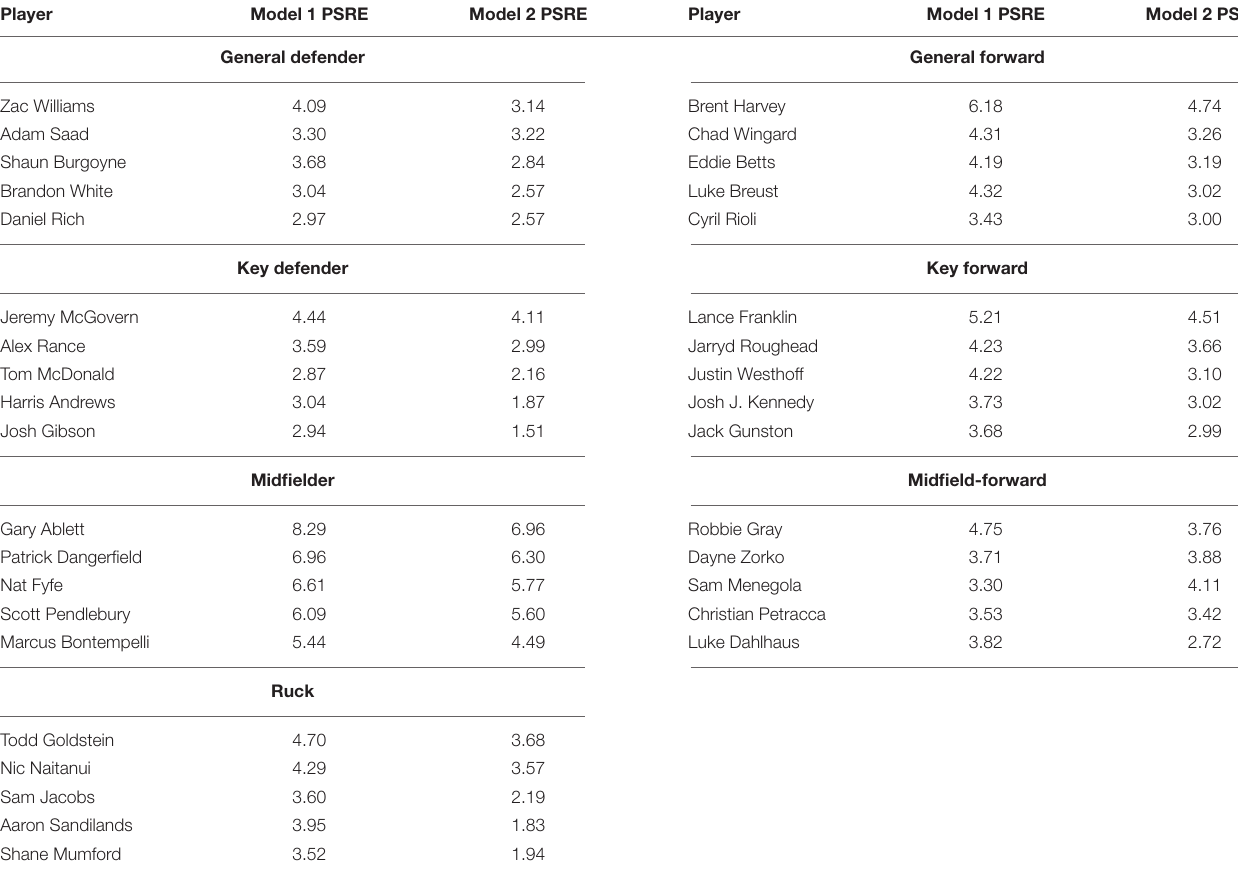
TABLE 3 | Top five players in each positional role, as determined by the average of the player specific random effects (PSRE) in each of the linear mixed models.